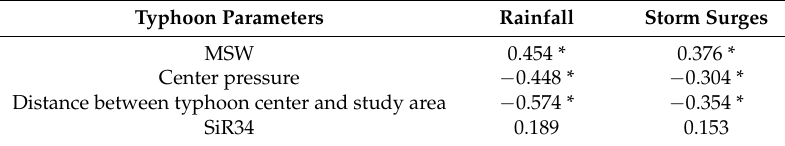
Table 1. Pearson’s correlation coefficient between typhoon parameters and rainfall and storm surges. Typhoon